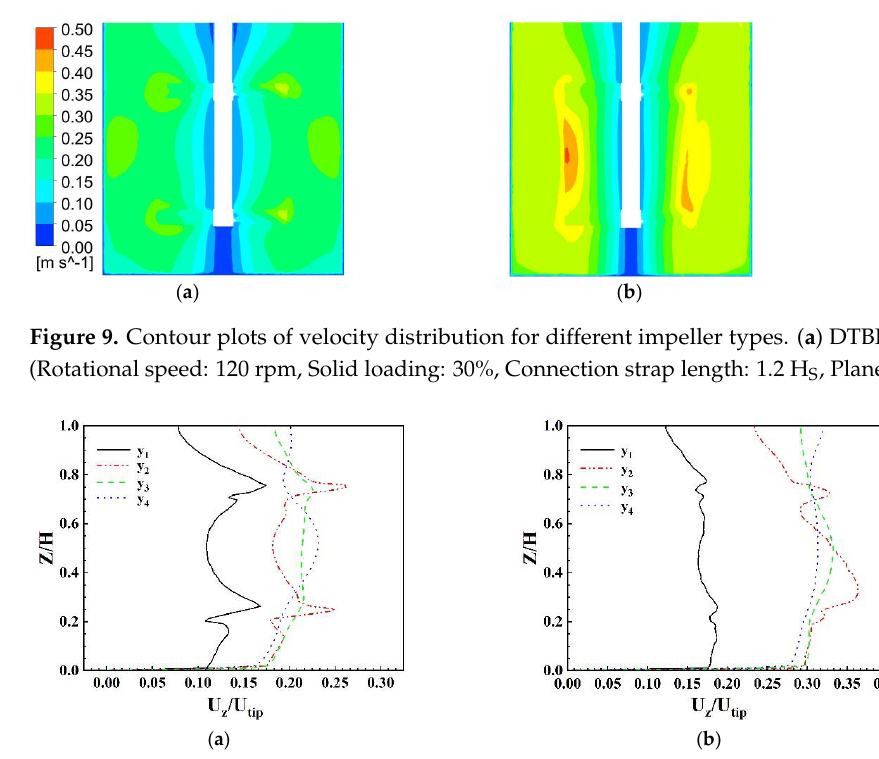
( b ) Figure 8. Axial solid concentration profile at different axial locations. ( a ) DTBI; ( b ) DRFTBI. (Rota- tional speed: 120 rpm; solid loading: 30%; connection strap length: 1.2 H S .) 4.2.2. Comparison of Velocity Figure 9 shows the contour plots of velocity distribution for different impeller types.